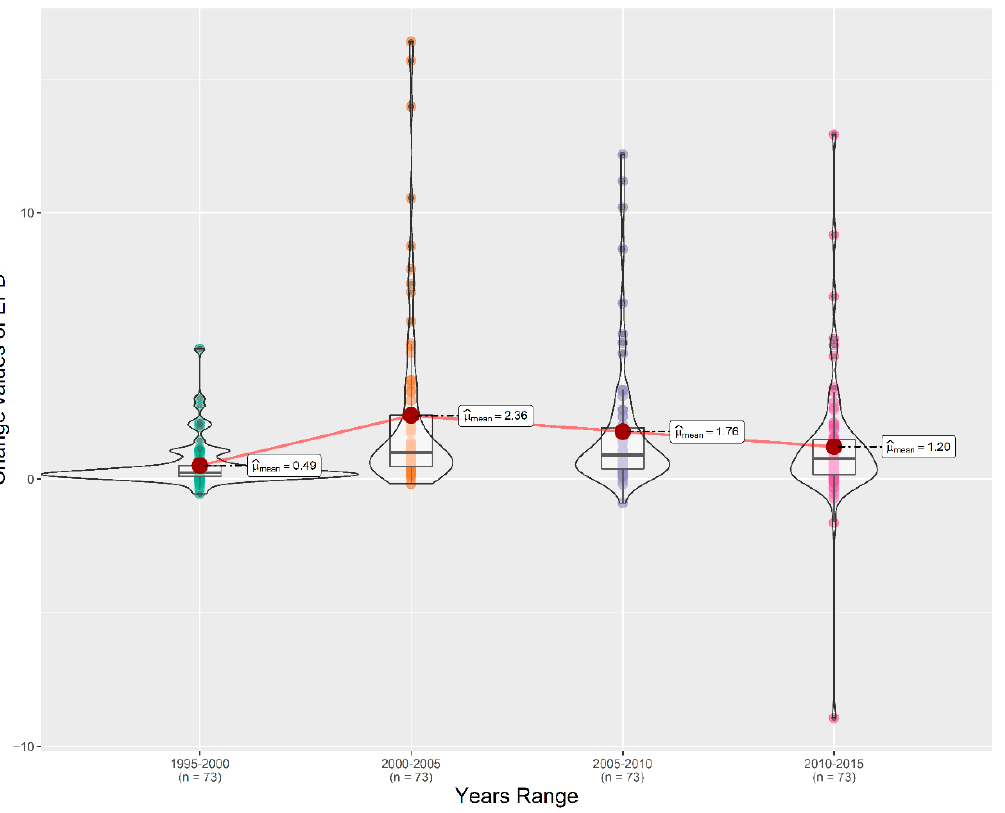
Figure 5. Change values of EFD of counties in Jiangsu Province in 1995–2015.